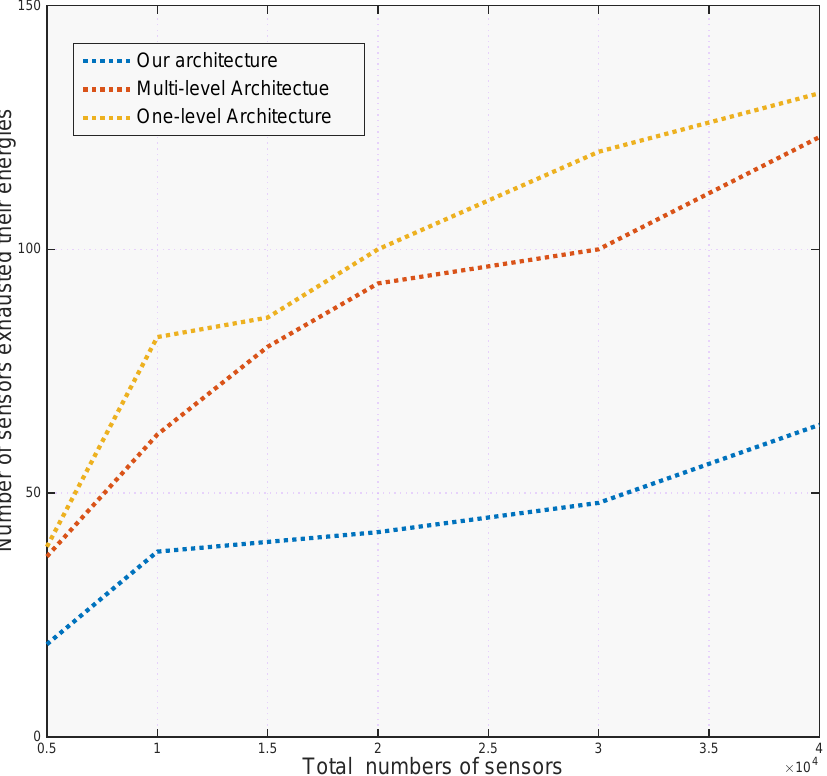
Figure 11. Number of sensors having exhausted their energies at the end of the simulation according to LEACH.